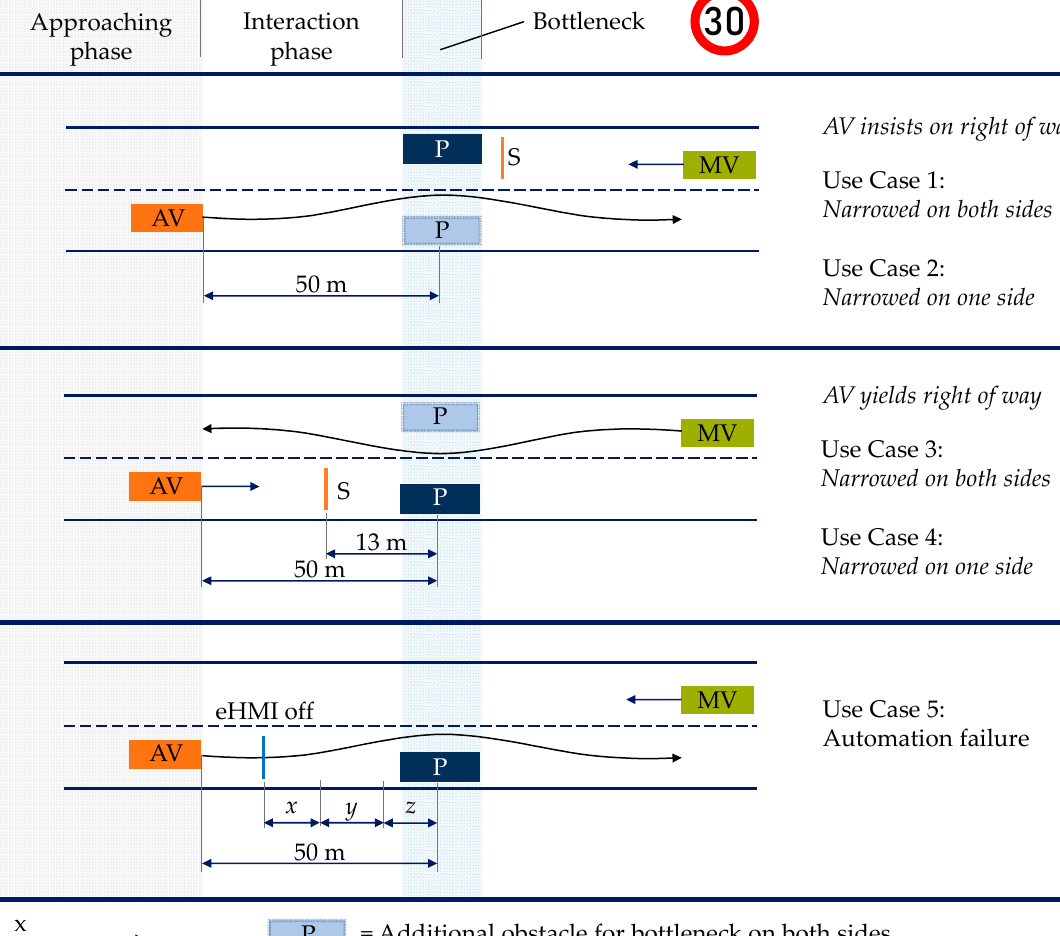
Figure 11. Different bottleneck scenarios the participants passed through during the experimental drive. The scenarios are located in the interaction phase with a speed limit of 30 km/h. In the interaction phase the AV communicates to the driver of the manual vehicle (MV) via the eHMI either to yield the right of way or to insist on it. [30]